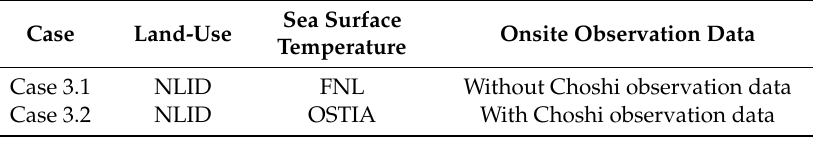
Table 5. Cases used to investigate the effect of sea surface temperature.